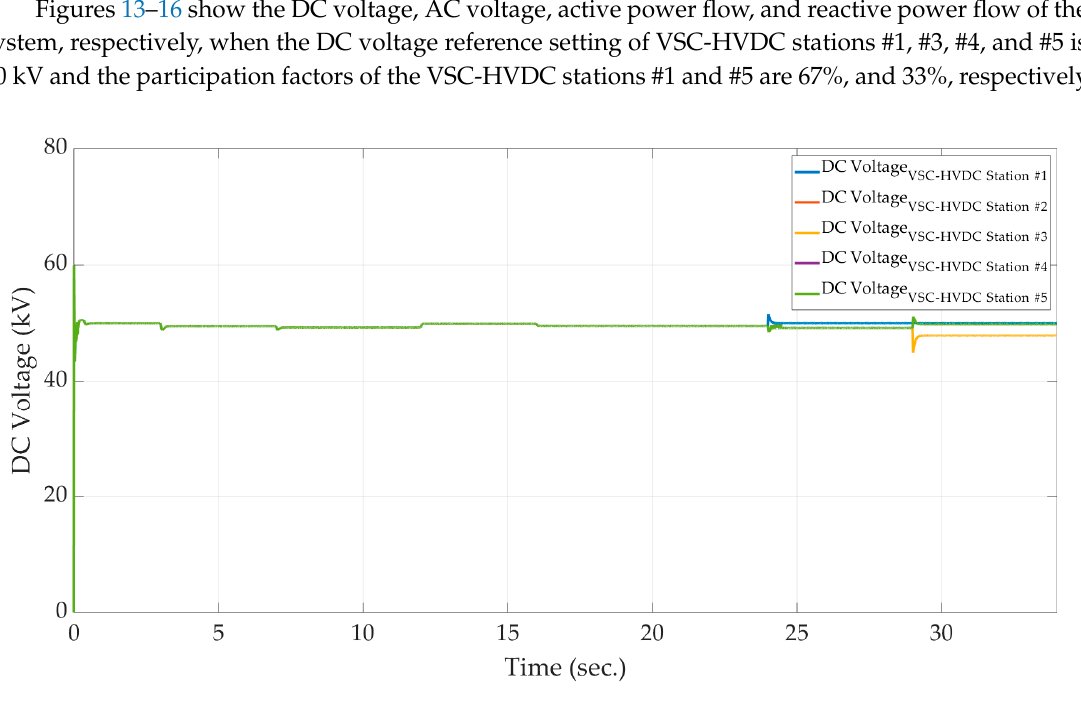
Figure 14. The AC voltage profile of different VSC-HVDC stations in the second scenario.